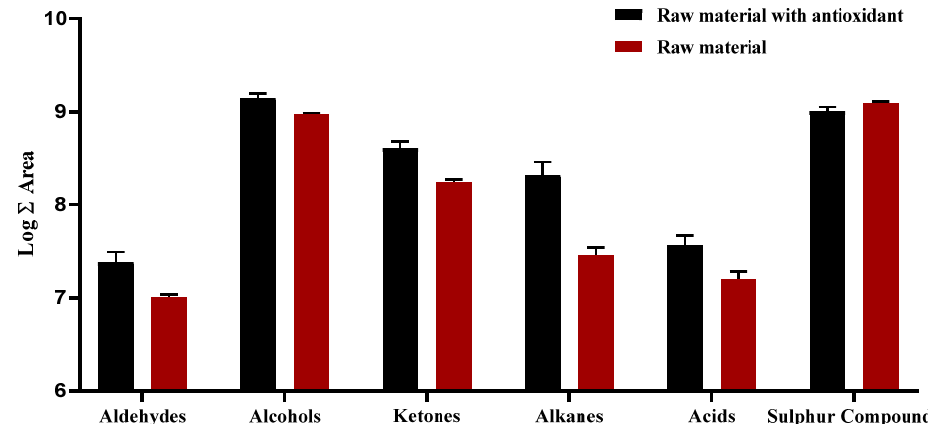
Figure 4. Effect of addition of antioxidant extract on the different classes of aroma compounds identified in sardine condensates.